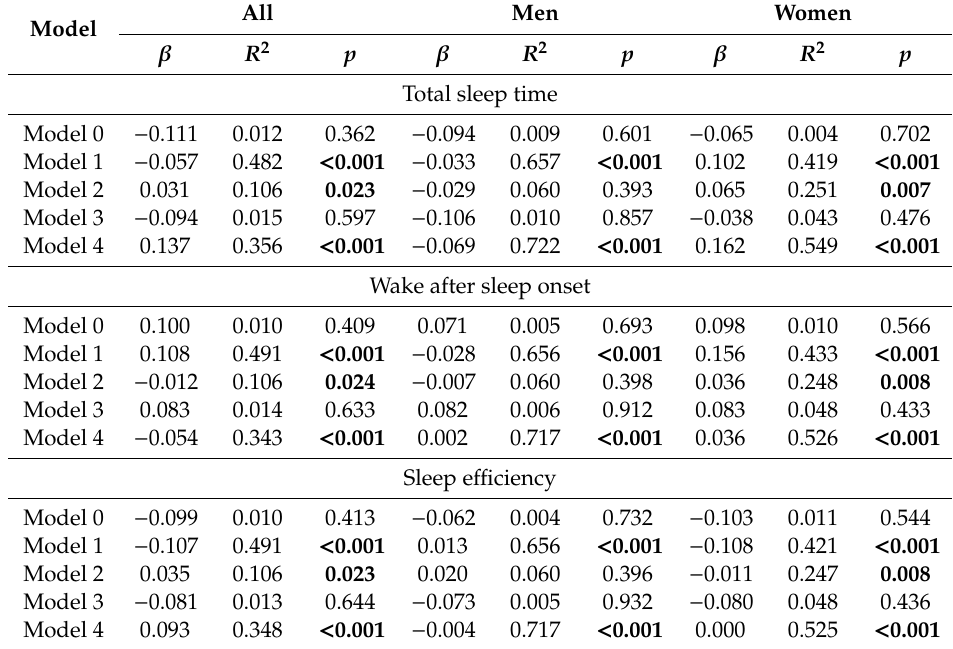
Table 2. Association of objective sleep quantity and quality with the secreted Klotho plasma levels (Model 0) adjusted by age (Model 1), total fat mass percentage (Model 2), fat mass index (Model 3), and lean mass index (Model